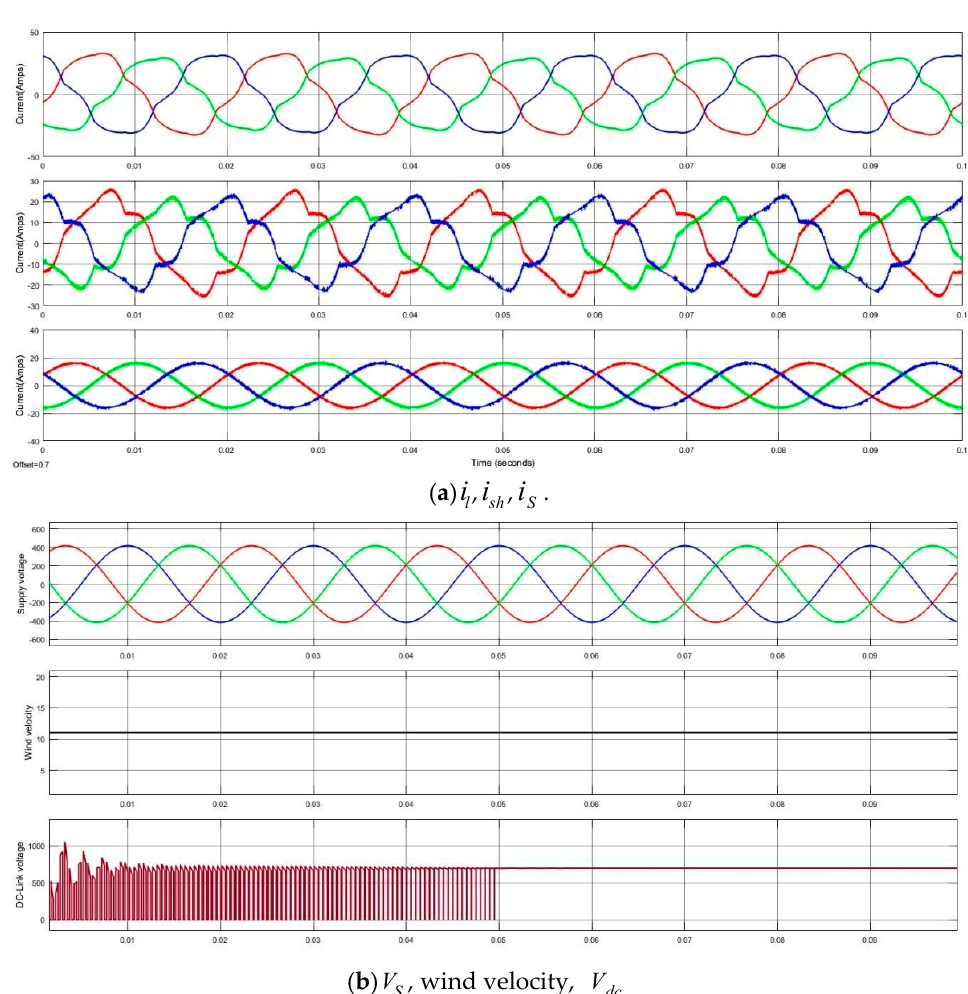
Figure 18. Waveforms for case 4.